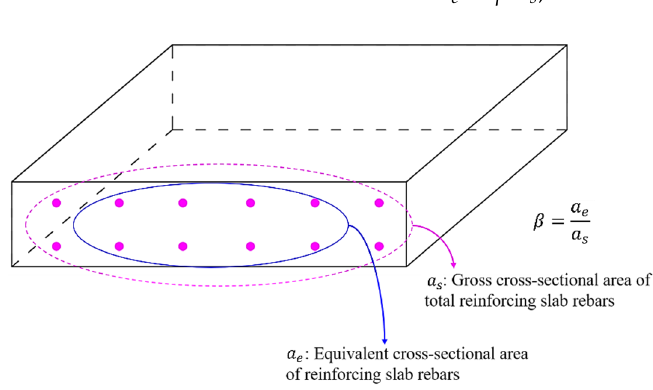
Figure 9. Definition of equivalent cross-sectional area ratio.